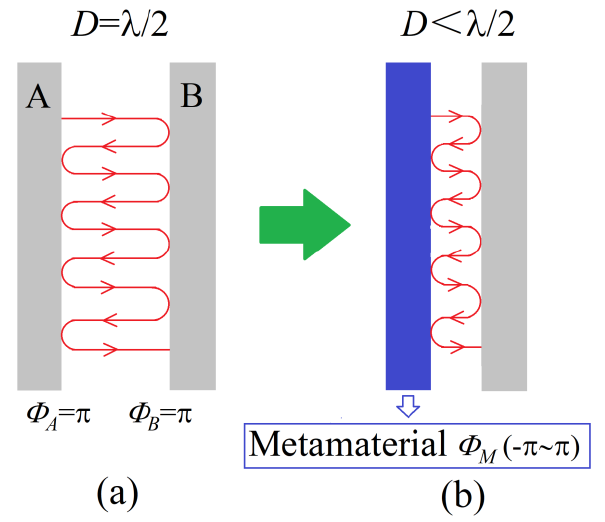
Figure 1. The schematic diagram of the structures of the cavity mode. ( a ) Traditional F-P cavity. ( b ) Metamaterial F-P cavity.